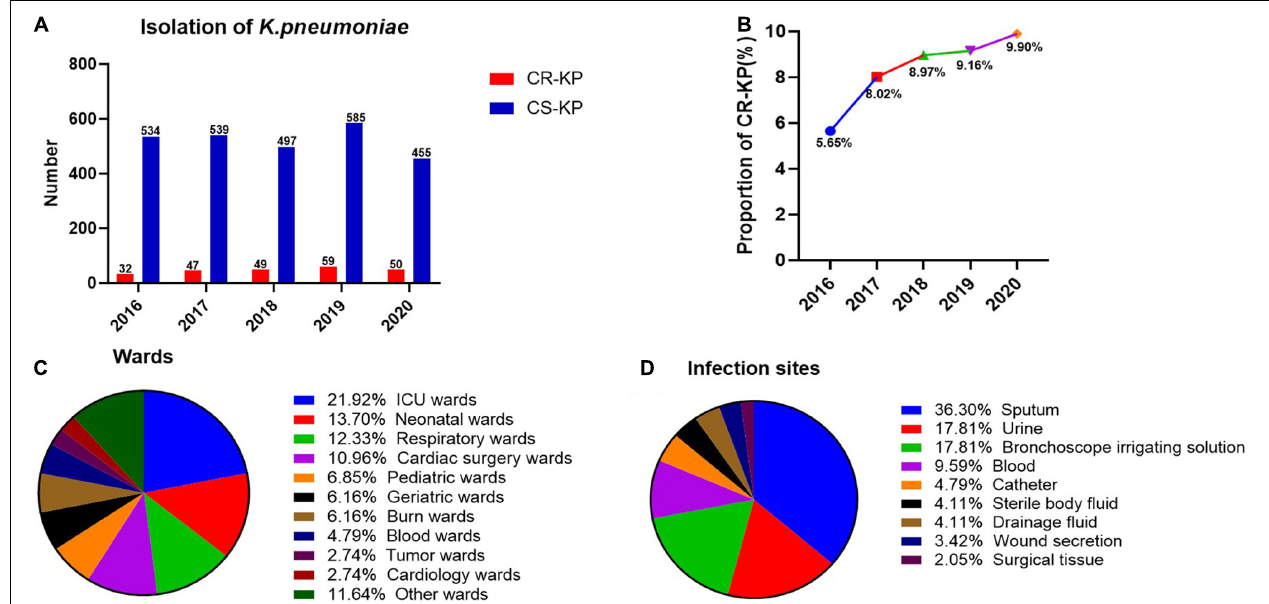
FIGURE 1 | The distribution of CR-KP. (A) Isolation of K. pneumoniae in 2016–2020. The x- and y-axes represents years and the number of strains, respectively. (B) Proportion of CR-KP in 2016–2020, The x- and y-axes represents years and rates, respectively. (C) Distribution of CR-KP in different wards. Colors represent the different wards, the proportion of wards are arranged from top to bottom. (D) Distribution of CR-KP in different infection sites. Colors represent the different infection sites, the proportion of infection sites are arranged from top to